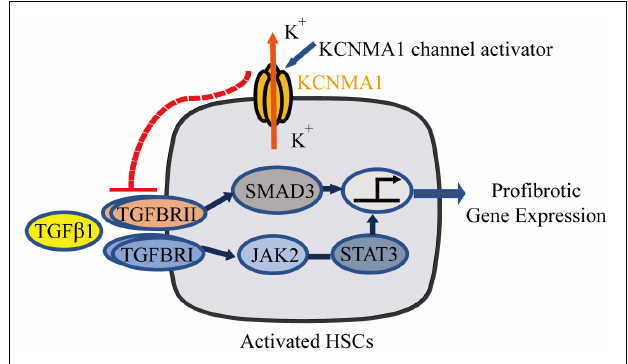
FIGURE 7 | Schematic diagram showing that upregulation of large-conductance and Ca 2 + -activated K + (BK) channel activity in activated hepatic stellate cells (HSCs) exerts an antifibrotic effect through suppressing of the profibrotic TGF β 1 signaling